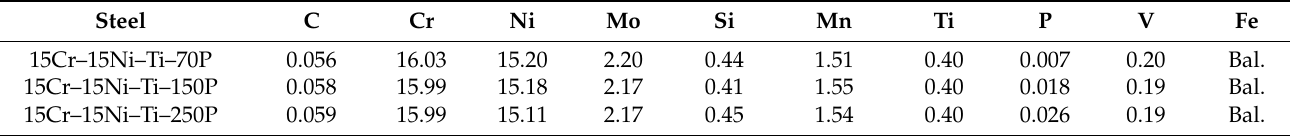
Table 1. Measured chemical compositions of three kinds of alloys